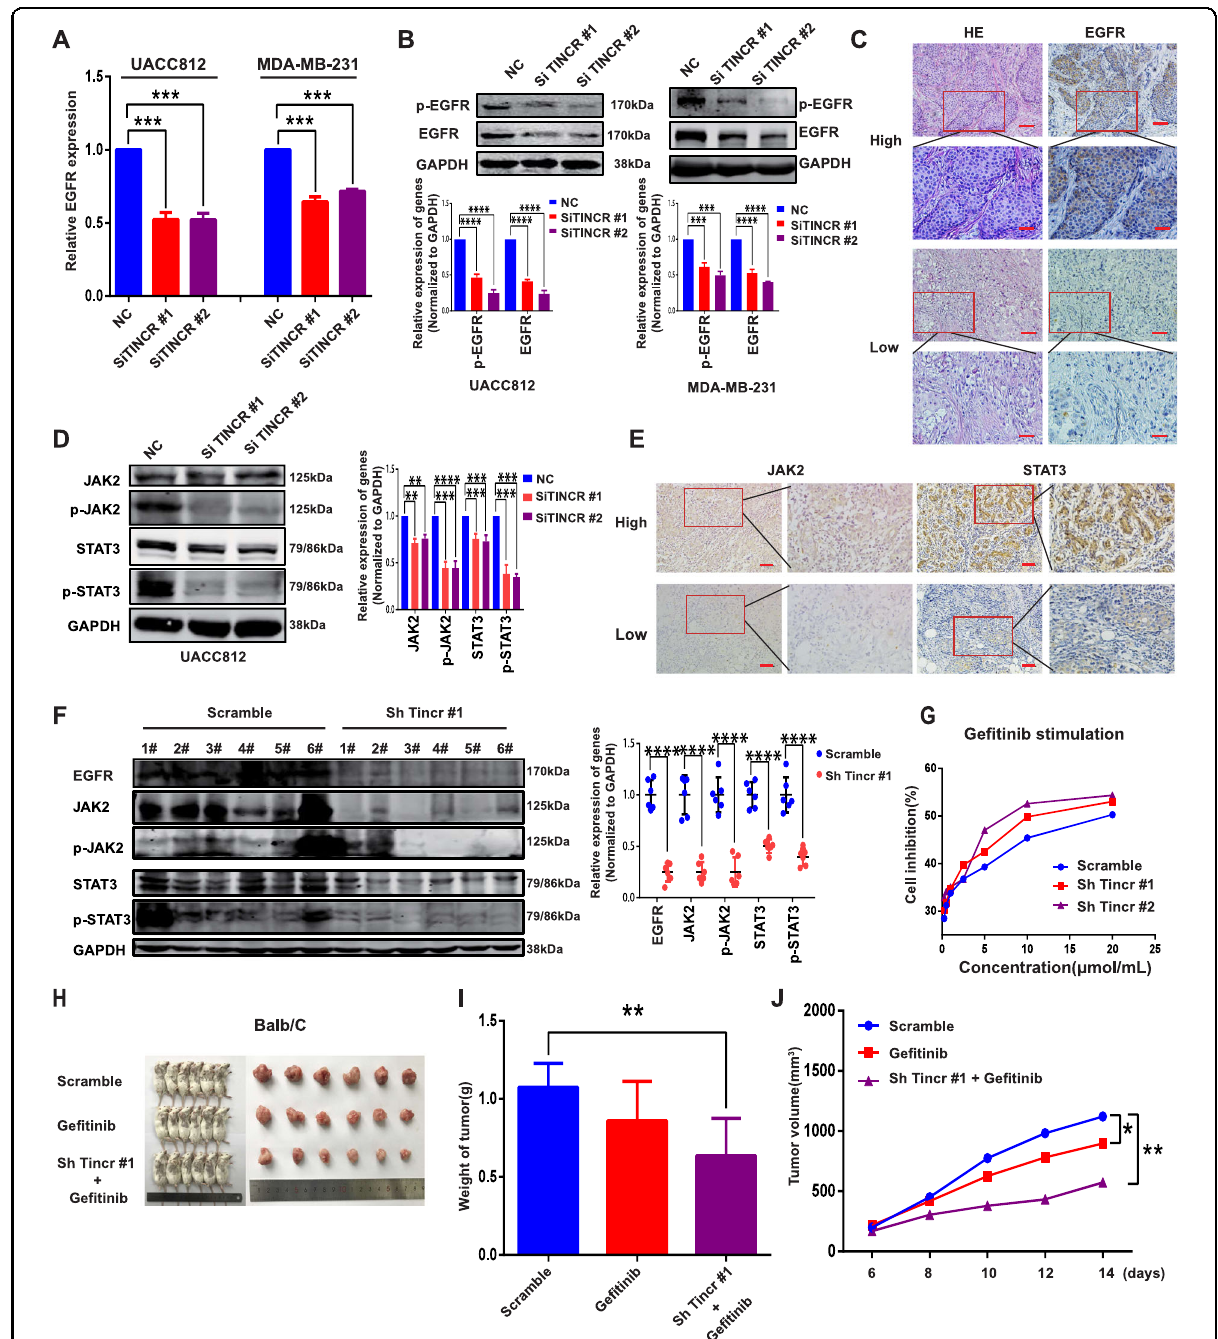
Fig. 4 TINCR regulates EGFR expression and downstream signaling in human cancer. a , b TINCR knockdown decreases expression of EGFR mRNA ( a ) and protein ( b ) in UACC 812 and MBA-MB-231 cells. c EGFR protein expression is higher in TINCR -high breast-cancer tissues than in TINCR -low tissues and vice versa in 122 patients in the HMUCC cohort. Scale bar, 400 μ m. d TINCR knockdown decreases the levels of p-JAK2, STAT3, and p- STAT3 in UACC 812 cells. e JAK2 and STAT3 protein expression is higher in TINCR -high breast-cancer tissues than in TINCR -low tissues and vice versa in 125 patients in the HMUCC cohort. Scale bar, 400 μ m. f TINCR knockdown decreases the levels of EGFR, JAK2, p-JAK2, STAT3, and p-STAT3 in vivo ( n = 6/group). g Ge fi tinib IC 50 analysis after Tincr knockdown. h Tumorigenesis and tumor tissue of each group of Balb/c mice ( n = 6/group). i , j Tumor growth and weight measured in Balb/c mice in each group. Tumors were measured at the indicated time points and dissected at the endpoint. Data are presented as means from three independent experiments± S.D. * P < 0.05, ** P < 0.01, *** P < 0.001, **** P < 0.0001.